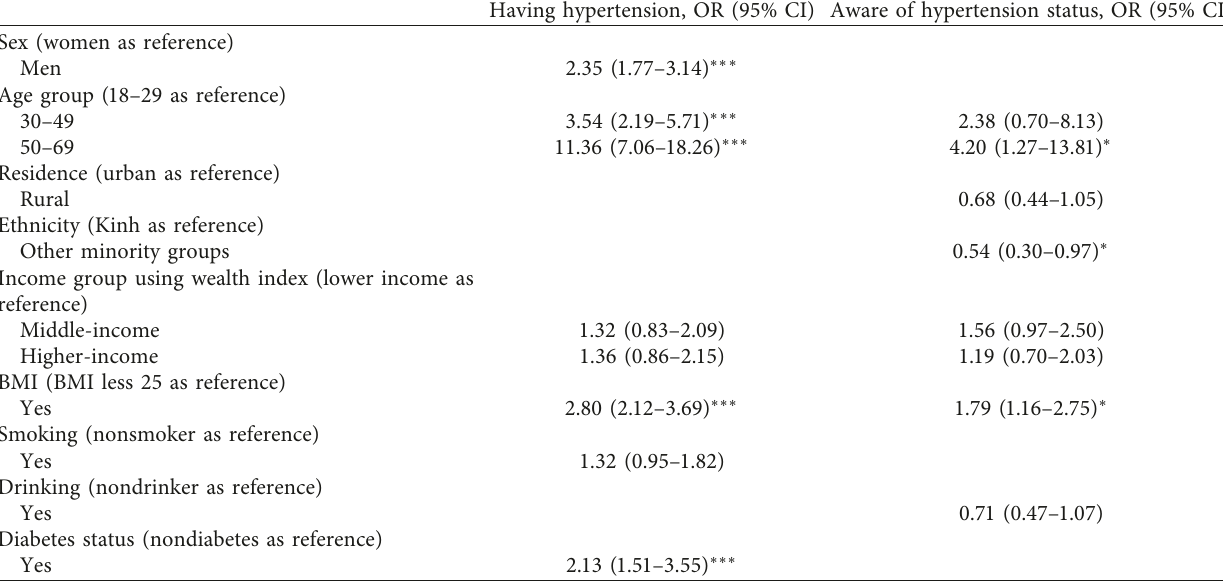
Table 4: Multiple regression analyses: association between sociodemographic factors and hypertension and awareness of hypertension status in Vietnam,